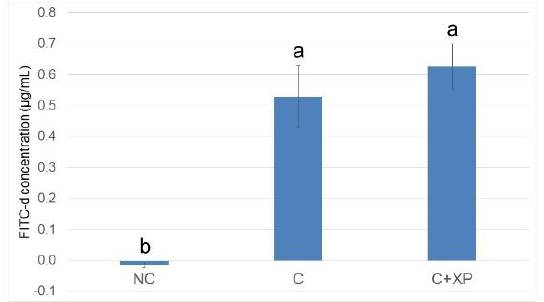
Figure 1. Fluorescein isothiocyanate dextran concentration (FITC-d, µg/mL) in serum of broiler chickens in response to feeding HFAP diet with or without enzyme supplementation (Expt. 1). Treatments with different letters are significantly different ( p < 0.05). N = 6. NC, unchallenged (no enzyme) treatment; C, challenged (no enzyme) treatment; C+XP, challenged and supplemented with xylanase and protease treatment. The error bars represent the SEM values.